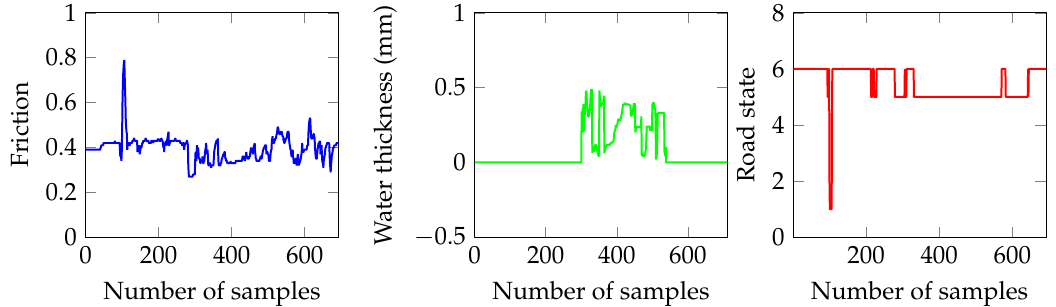
Figure 2. Three of the possible data types that can be extracted from the RCM411: ( left ) friction; ( middle ) water thickness; and ( right ) road